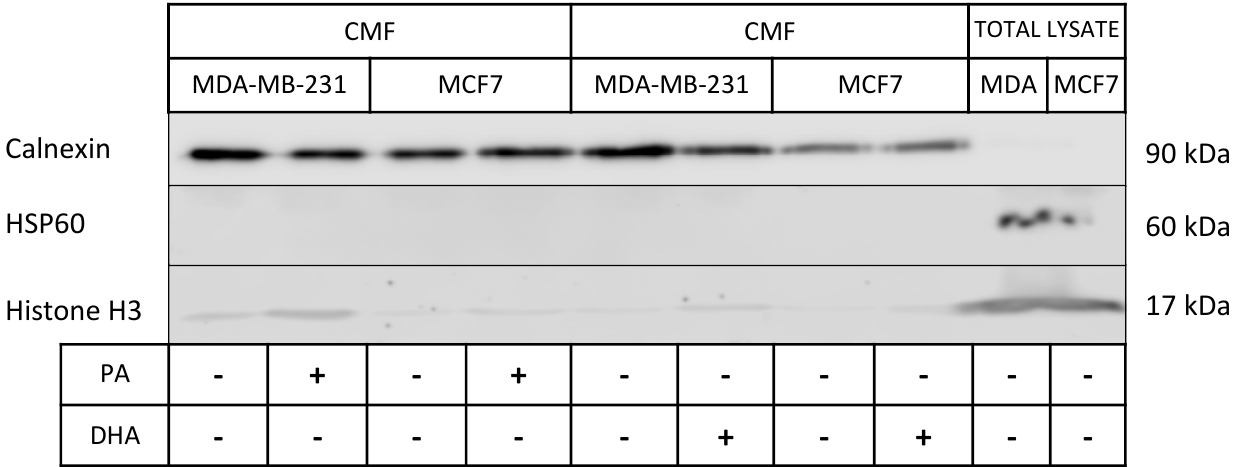
Figure 4. Characterization of microsomal fractions (CMF) purified from control and PA- or DHA-treated breast cancer MDA-MB-231 and MCF7 cells (50 µM) for 72 h: the purity of the microsomal fractions (endoplasmic reticulum (ER)) is evaluated using positive ER markers, such as Calnexin, and markers from other cell compartments, such as HSP60 and histone H3.